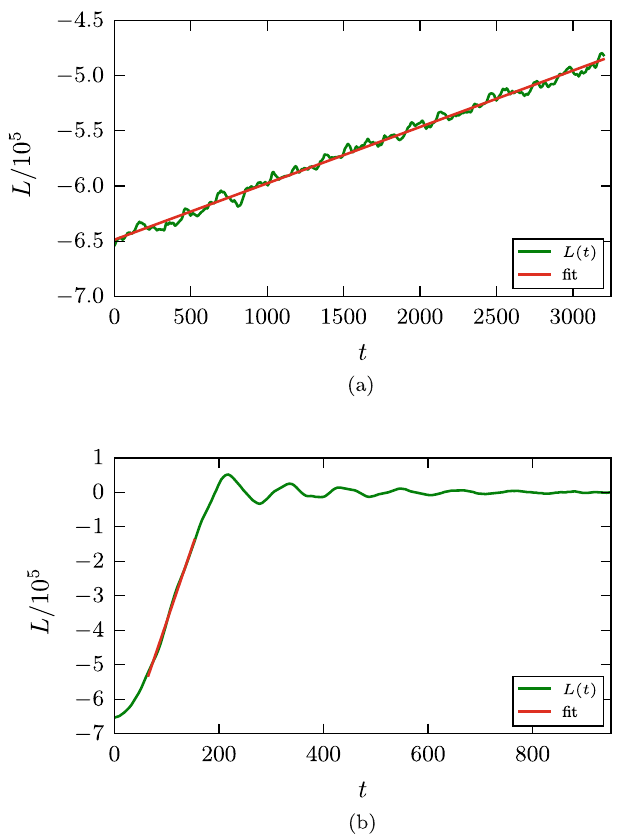
Figure 6. Rolling simulation: Temporal evolution of the angular momentum L for an intergrain attraction ǫ 12 = 0.25 ( a ) and ǫ 12 = 0.75 ( b ) for an initial value of the angular velocity ω = 0.04